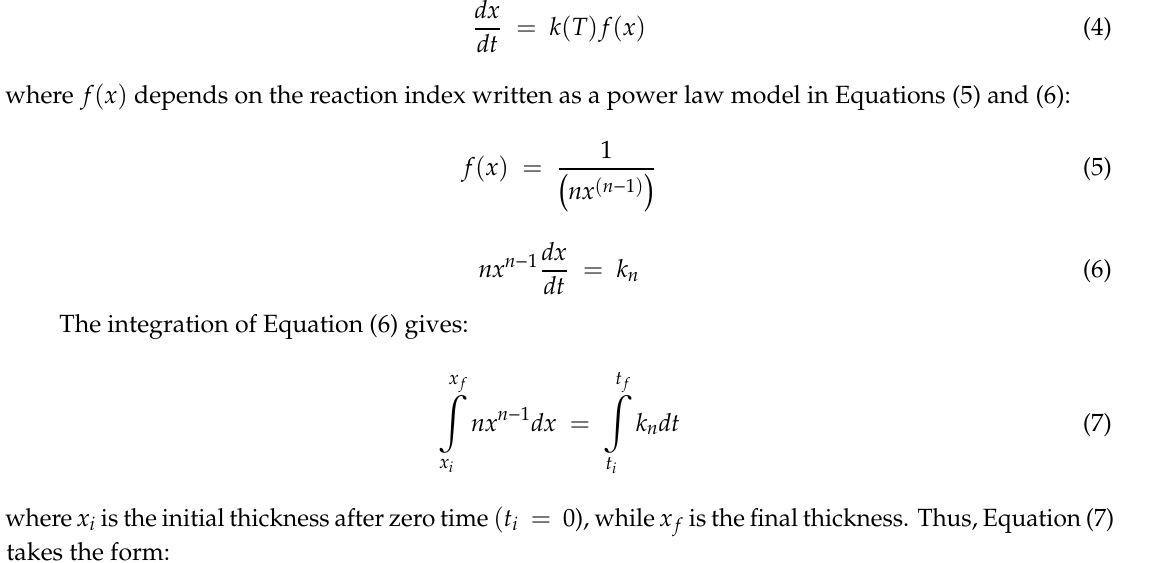
Plastic Work (GPa) Elastic Work